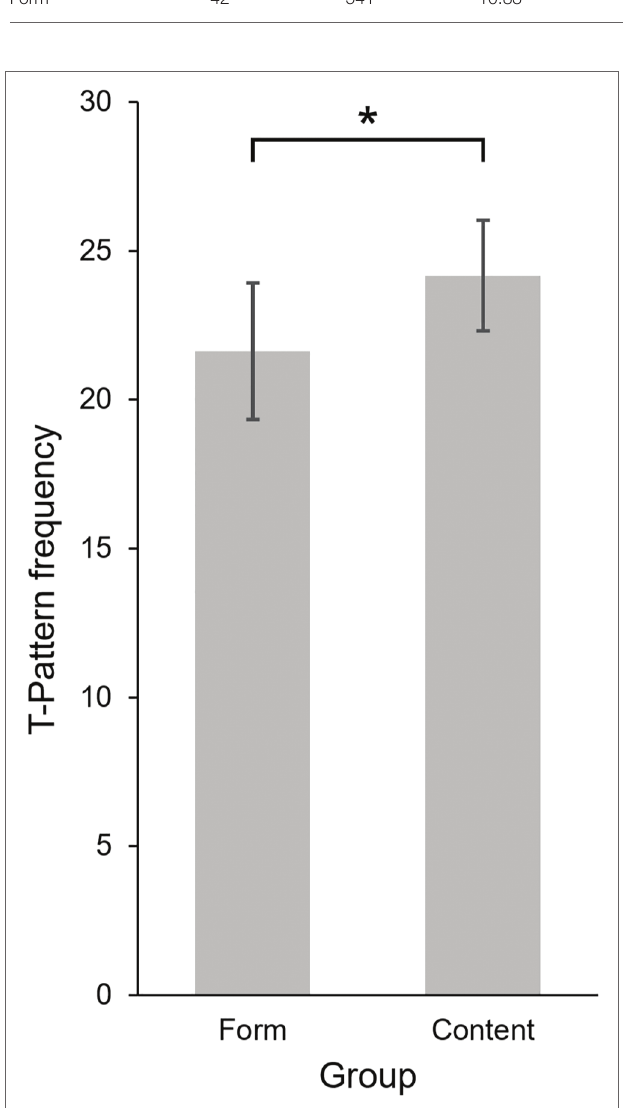
FIGURE 3 | Mean frequencies of T-patterns with blinks and peaks in optical flow in the form condition and content condition. Error bars indicate 95% CIs of the SEM. * p <